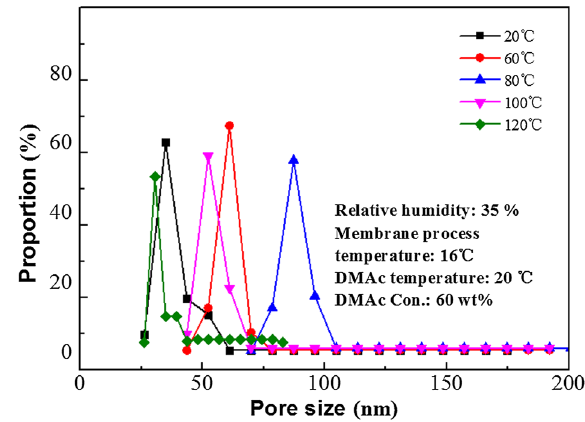
Fig. 9 The pore size distributions of membranes prepared in different casting solution temperature